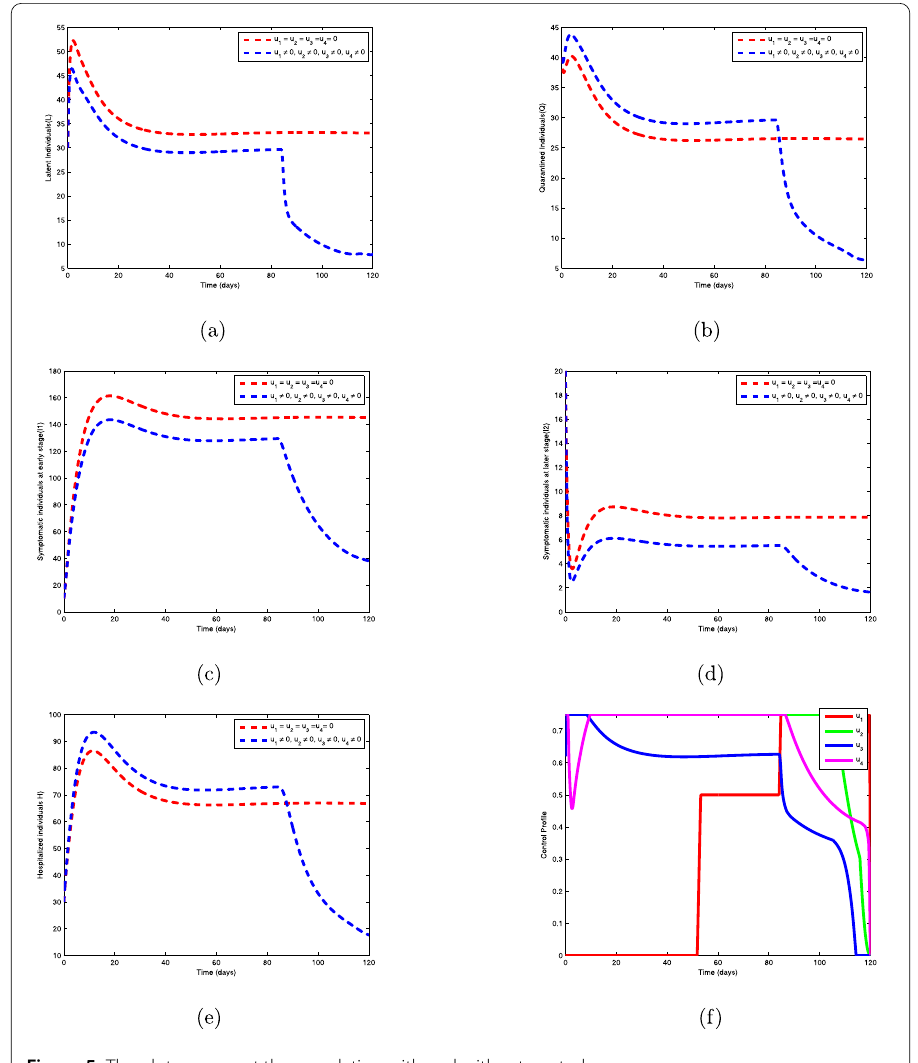
Figure 5 The plots represent the population with and without control